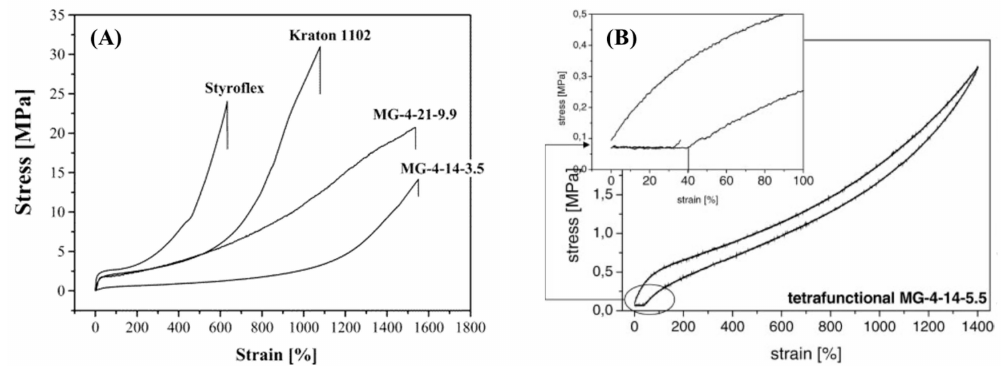
Figure 16. ( A ) Stress–strain behavior of tetrafunctional multigraft copolymers compared to